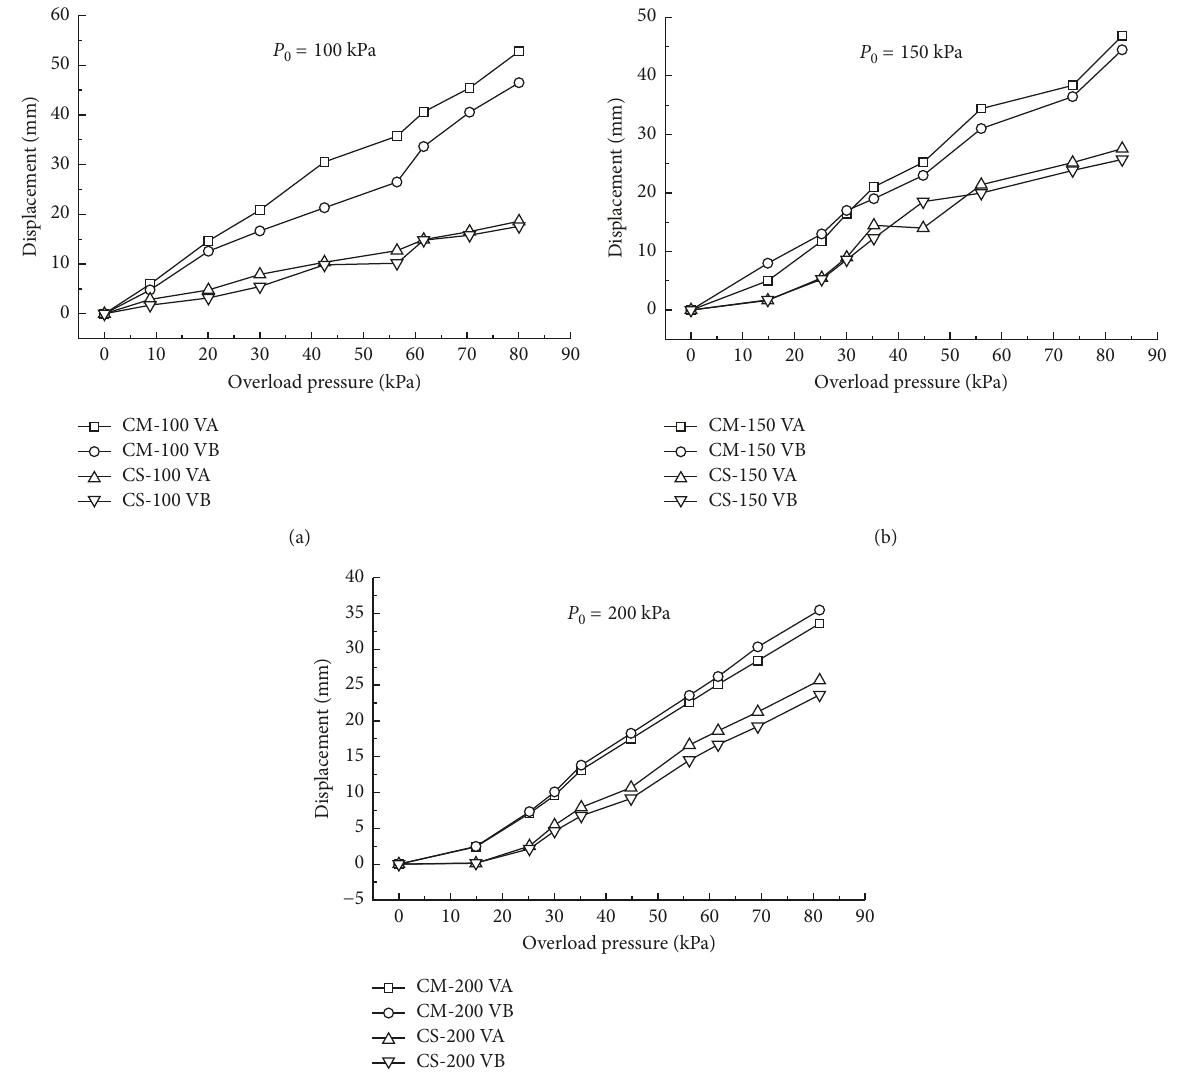
Figure 13: The relationship of vertical displacement to overload pressure: (a) initial pressure P and (c) initial pressure P 0 �